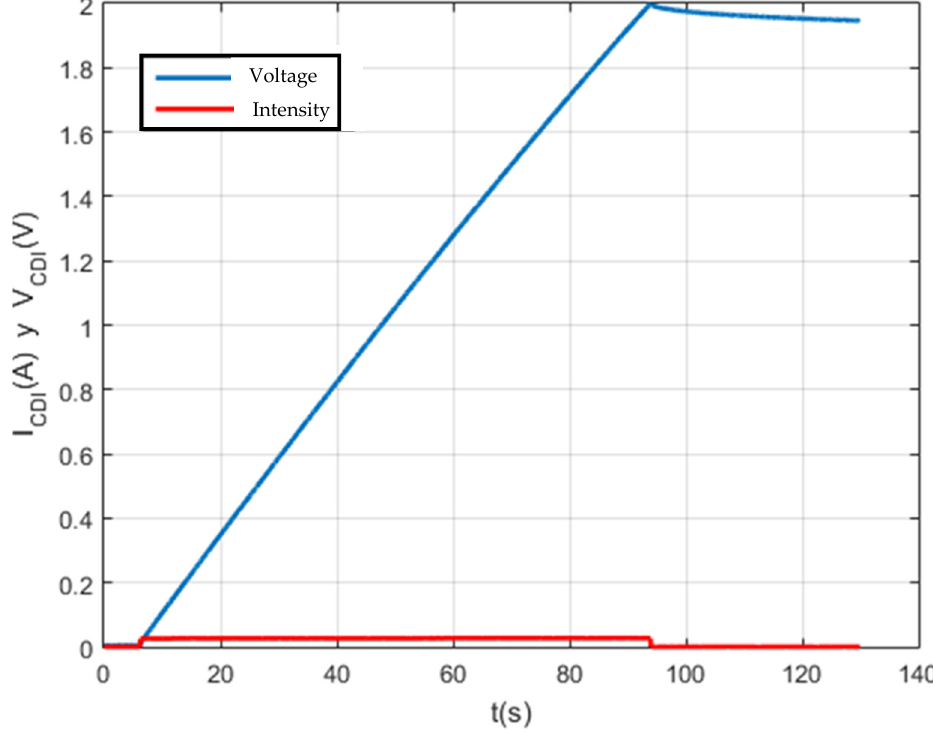
Figure 12. Charge and self-discharge test at Vc max = 2 V and Ic = 0.025 A. On the other hand, the system was validated with another supercapacitor, with a capacity of 650 F at another maximum voltage and setpoint current. The test results can be seen in the following figure.